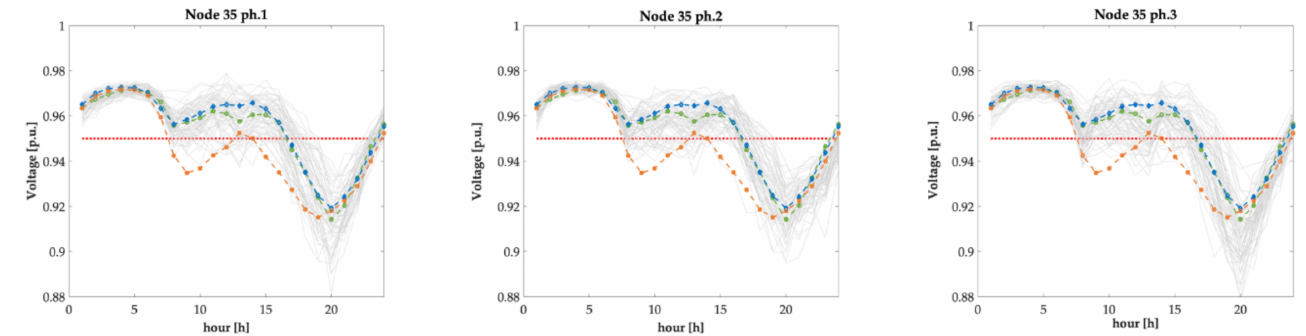
Figure 21. Voltage profile of the node N_35 during the winter working day (real days in light grey, mean of real day values in green, DSO’s LPs in orange, and new LPs in blue; voltage limit in